Question: What does this figure show? Answer in one sentence.
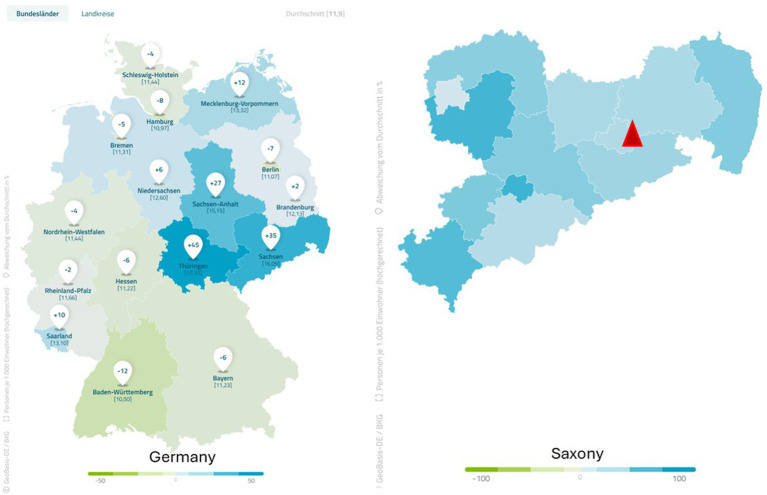
Answer: Distribution of referring healthcare providers and referred epilepsy patients from Saxony to the specialized center in 2022 and 2024.